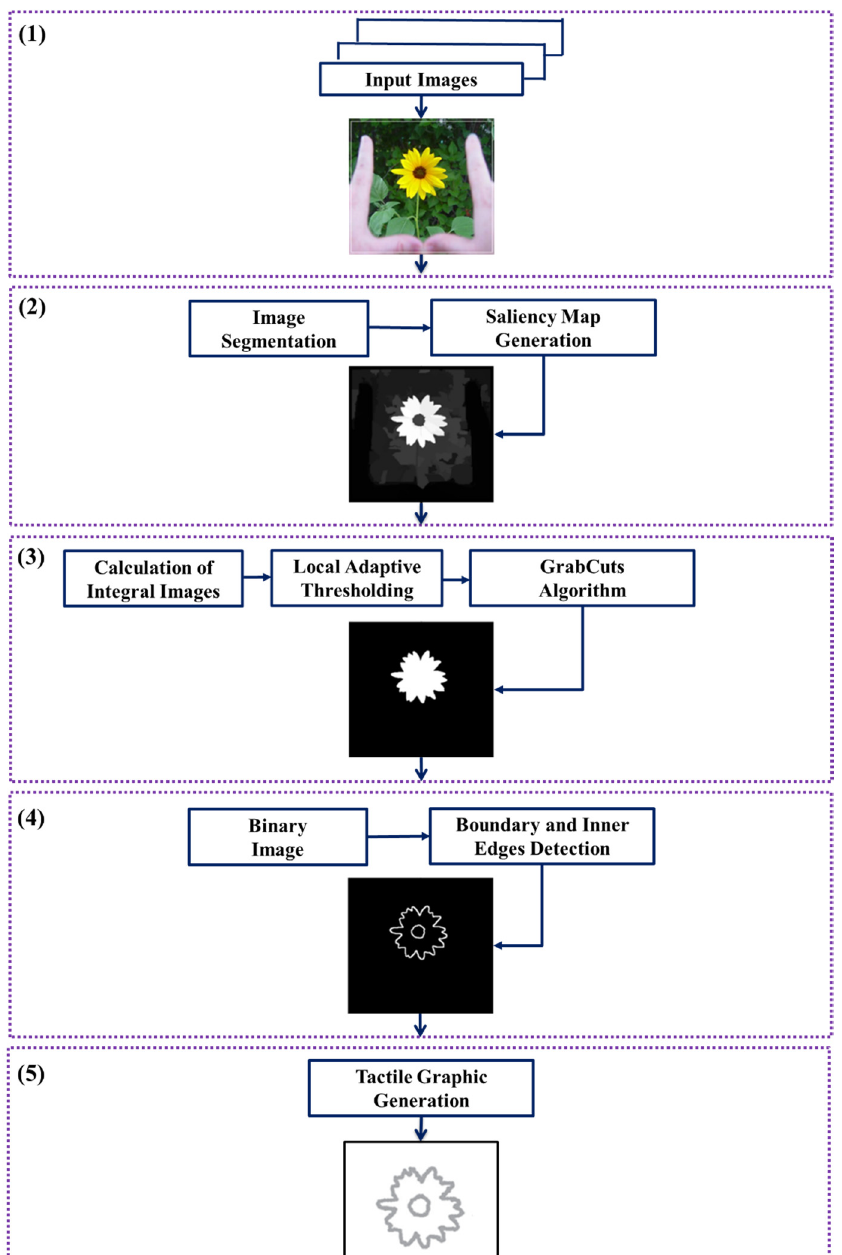
Figure 3. A flowchart of the proposed method: (1) Input natural scene image, (2) saliency map generation using our previous approach, (3) saliency cuts using local adaptive thresholding, (4) outer boundary and inner edge detection, (5) tactile graphics for visually impaired.